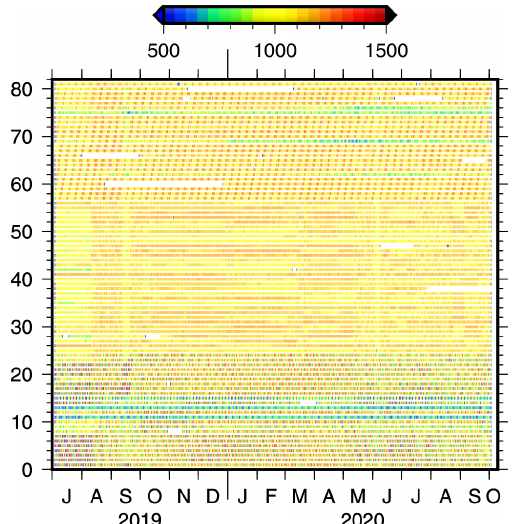
Figure 2. Number of L1 observations (phase of first frequency) per day and satellite; observation types are L1X for Galileo (rows 1– 25), L1W for GPS (rows 26–57), L1P for GLONASS (rows 58–82) for the GNSS receiver at RV Polarstern